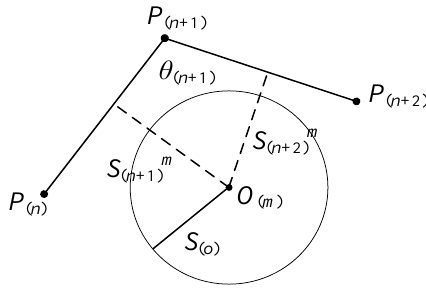
Figure 4. Principle diagram of fitness functions design.